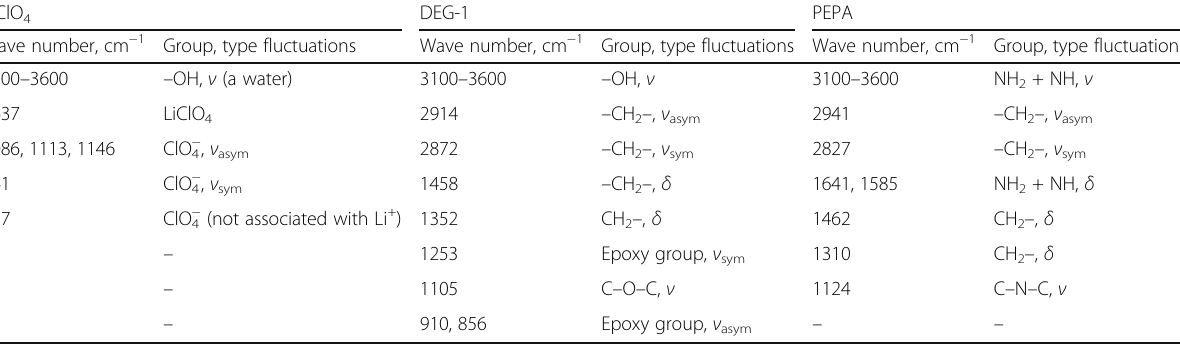
Table 1 Interpretation of the absorption band IR spectra of LiClO 4 , DEG-1, and PEPA LiClO